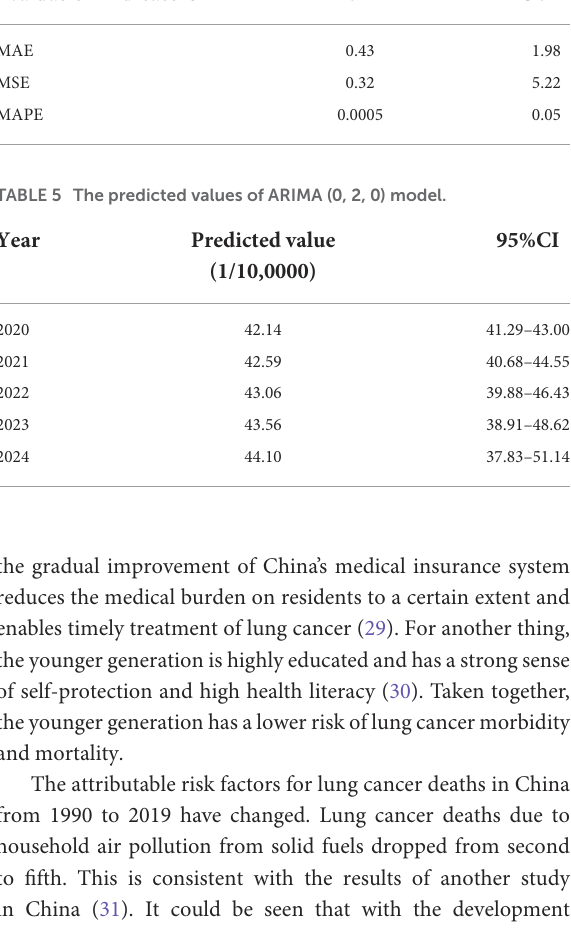
TABLE 4 Evaluation of the fitting effects of the two models. Evaluation indicators